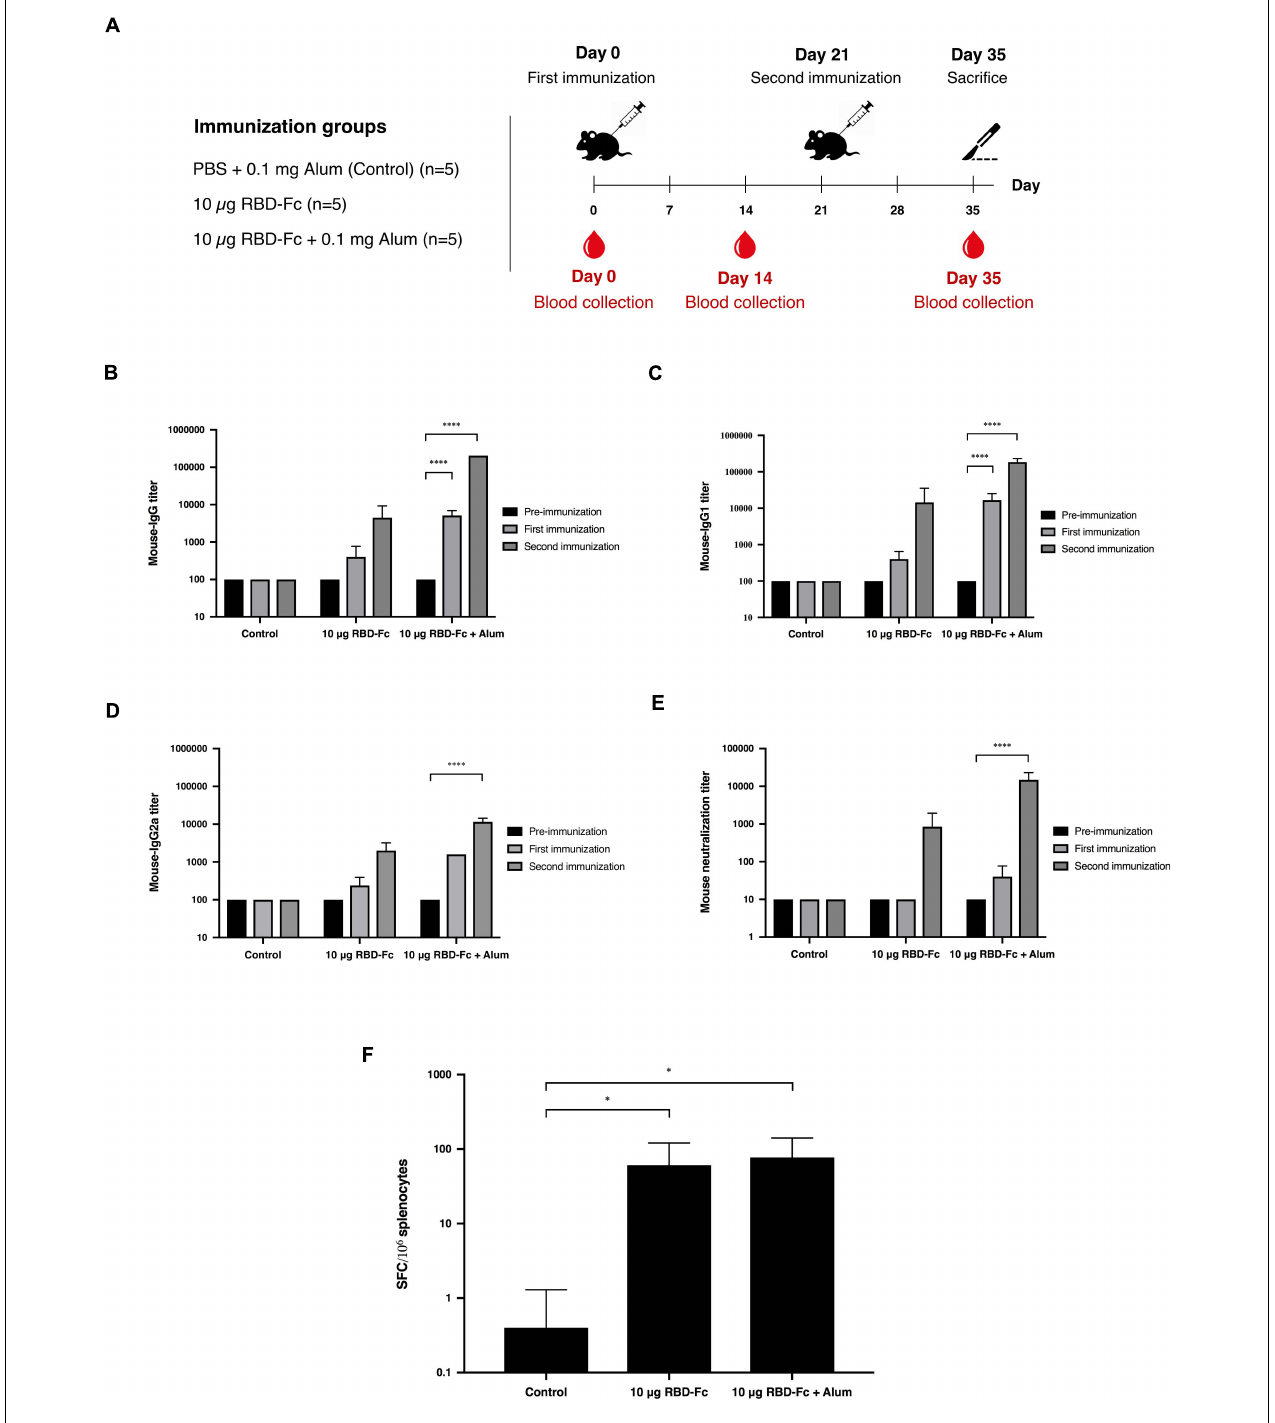
FIGURE 4 | Immunogenic studies in mice. Schematic representation of immunization protocol and sample collection. Groups of mice (five mice per each group) were intramuscularly immunized with 10 µ g of SARS-CoV-2 RBD-Fc fusion protein alone or with alum adjuvant, followed by booster dose at 21 days after first immunization. Mice sera were collected on day 0 (pre-bleed) and day 14 post-immunization (A) . Titers of SARS-CoV-2 RBD-specific total IgG (B) , IgG1 (C) , and IgG2a (D) in the immunized sera collected on day 0, 14, and 35 were analyzed by indirect ELISA using Sf9-produced SARS-CoV-2 RBD-His as the capture antigen. Potent neutralizing antibody titers in mice sera were tested by in vitro microneutralization assay using Vero E6 cell line and live SARS-CoV-2 (E) . The functional profiles of SARS-CoV-2 RBD-specific T-cell responses expressing in mouse splenocytes immunized with plant-produced SARS-CoV-2 RBD-Fc adjuvanted with alum were determined by mouse ELISpot assay (F) . Data presented as mean ± SD of the endpoint titers in each mice vaccination group ( n = 5). ∗ p < 0.05; ∗∗ p < 0.01; ∗∗∗ p < 0.001; ∗∗∗∗ p < 0.0001.